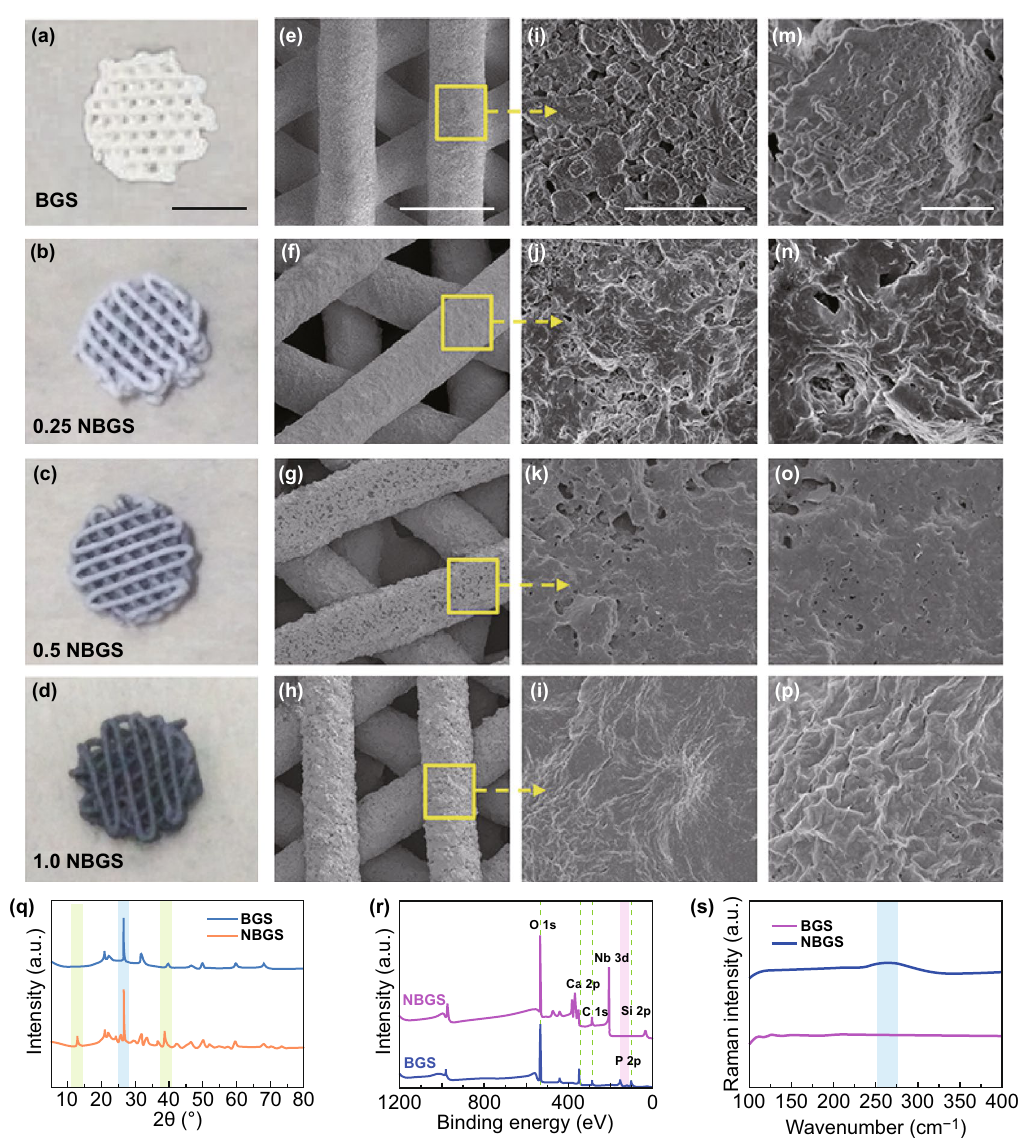
Fig. 2 Synthesis and characterization of 3D NBGS. a–d Digital photographs of BGS and NBGS with 3D geometrical structure. The scale bar is 3 mm. e - p Photographs and different magnifications of SEM images of NBGS and BGS. From left to right, the scale bar is 500 μm, 5 μm and 1 μm, respectively. q XRD patterns of BGS and NBGS. r XPS spectra of BGS and NBGS. s Raman survey of BGS and NBGS. (Color figure